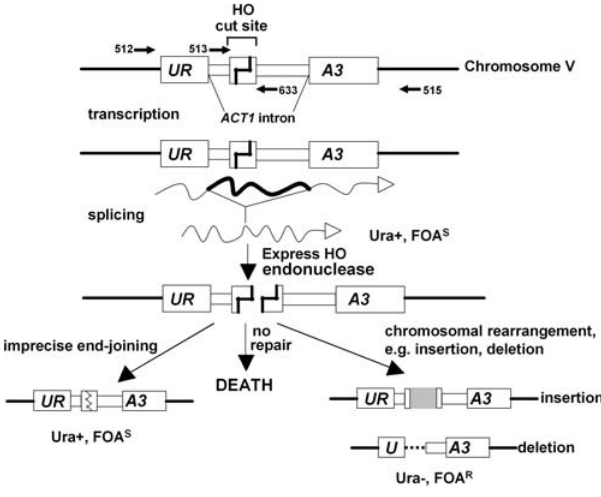
Figure 1. The experimental system. Structure of the URA3 allele on S. cerevisiae chromosome V used for these experiments. The position of various oligonucleotide primers (numbers and half arrows) used for PCR and sequencing are shown. The ACT1 intron placed into URA3 is normally spliced, resulting in uracil prototrophy (Ura + ) and sensitivity to the drug FOA S . After creating a DSB within the engineered ACT1 intron with HO endonuclease, cells either die, are repaired in a way allowing normal splicing, or are repaired in a way that prevents splicing. The latter situation leads to a phenotype of uracil auxotrophy (Ura 2 ) and resistance to 5-FOA (FOA R